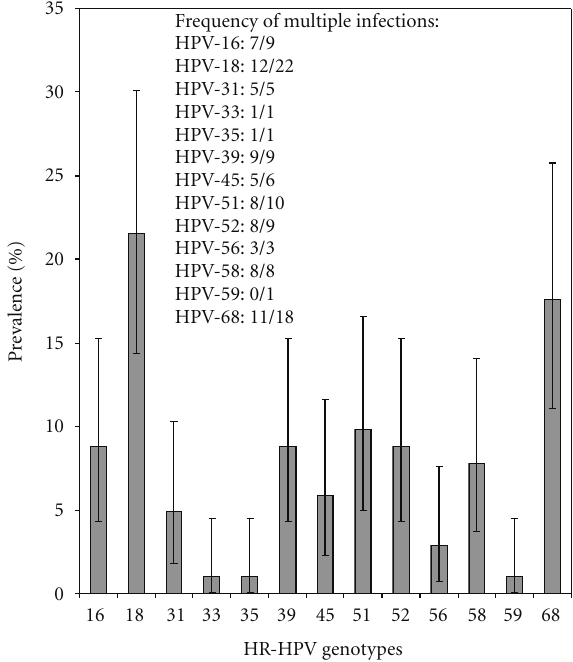
Figure 1: Distribution of the 102 high-risk human papillomavirus (HR-HPV) genotypes identified in the sample and frequency of multiple infections per HR-HPV genotype.